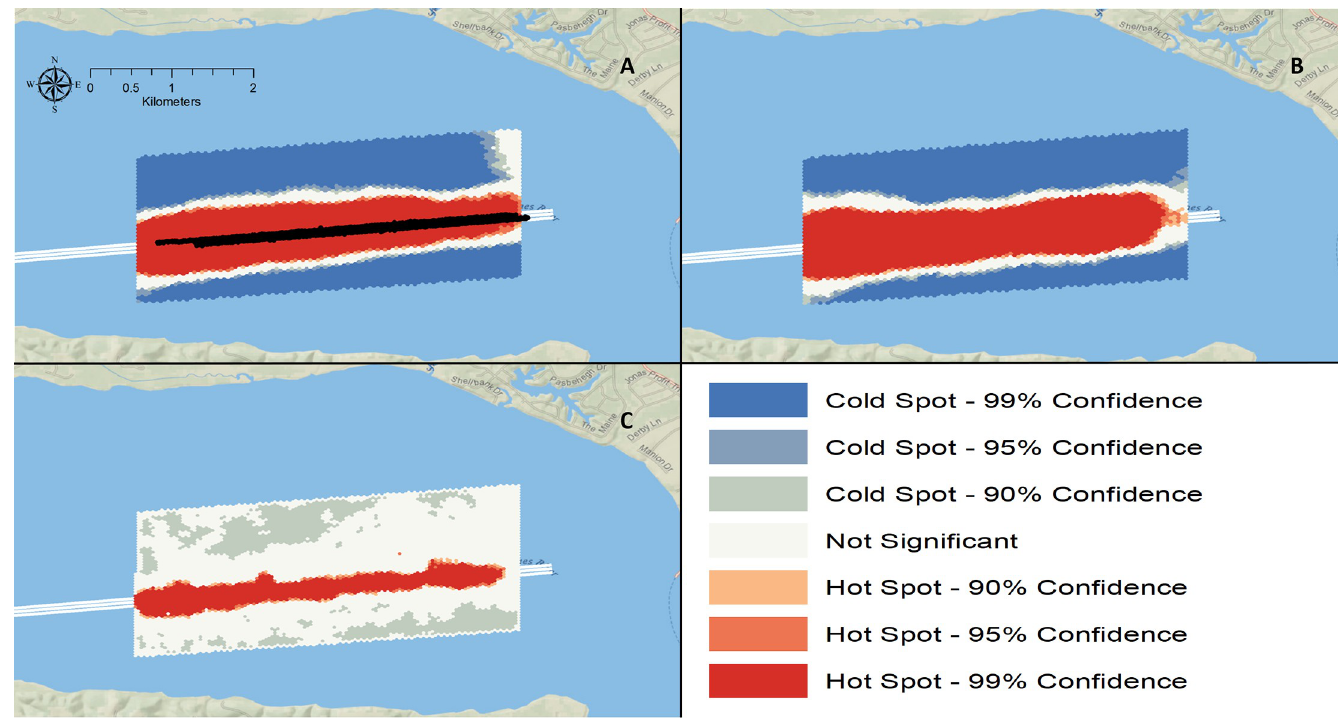
Fig 7. Results of the Getis Gi � Hotspot Analysis for when the dredge was working in the lower area (Panel A), working in the upper area (Panel B) and when no dredging was occurring (Panel C). The black dots in the middle of the hot spot in Panel A shows where the dredge was working during the lower area. The white polygon marks the federal navigation channel. All three plots show Atlantic sturgeon’s preference for the navigation channel either with or without a hydraulic- cutterhead dredge conducting dredge operations. Basemap reprinted from Ocean Basemap under a CC BY license, with permission from ESRI, original copyright 2012.